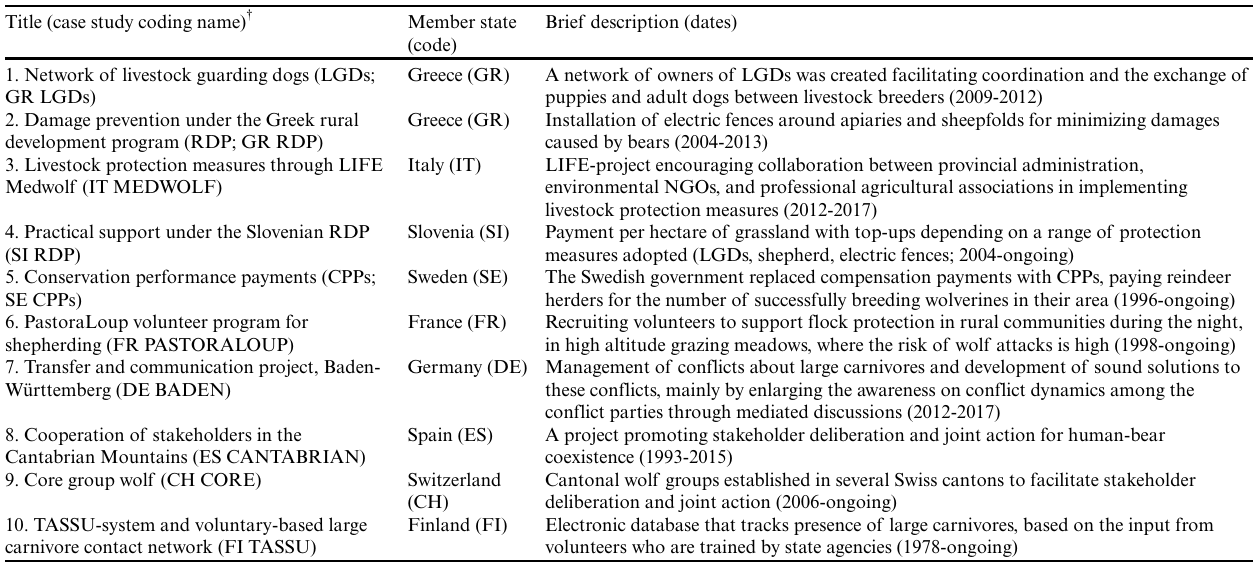
Table 1. Case studies depicting good practice in large carnivore conservation and management Title (case study coding name)